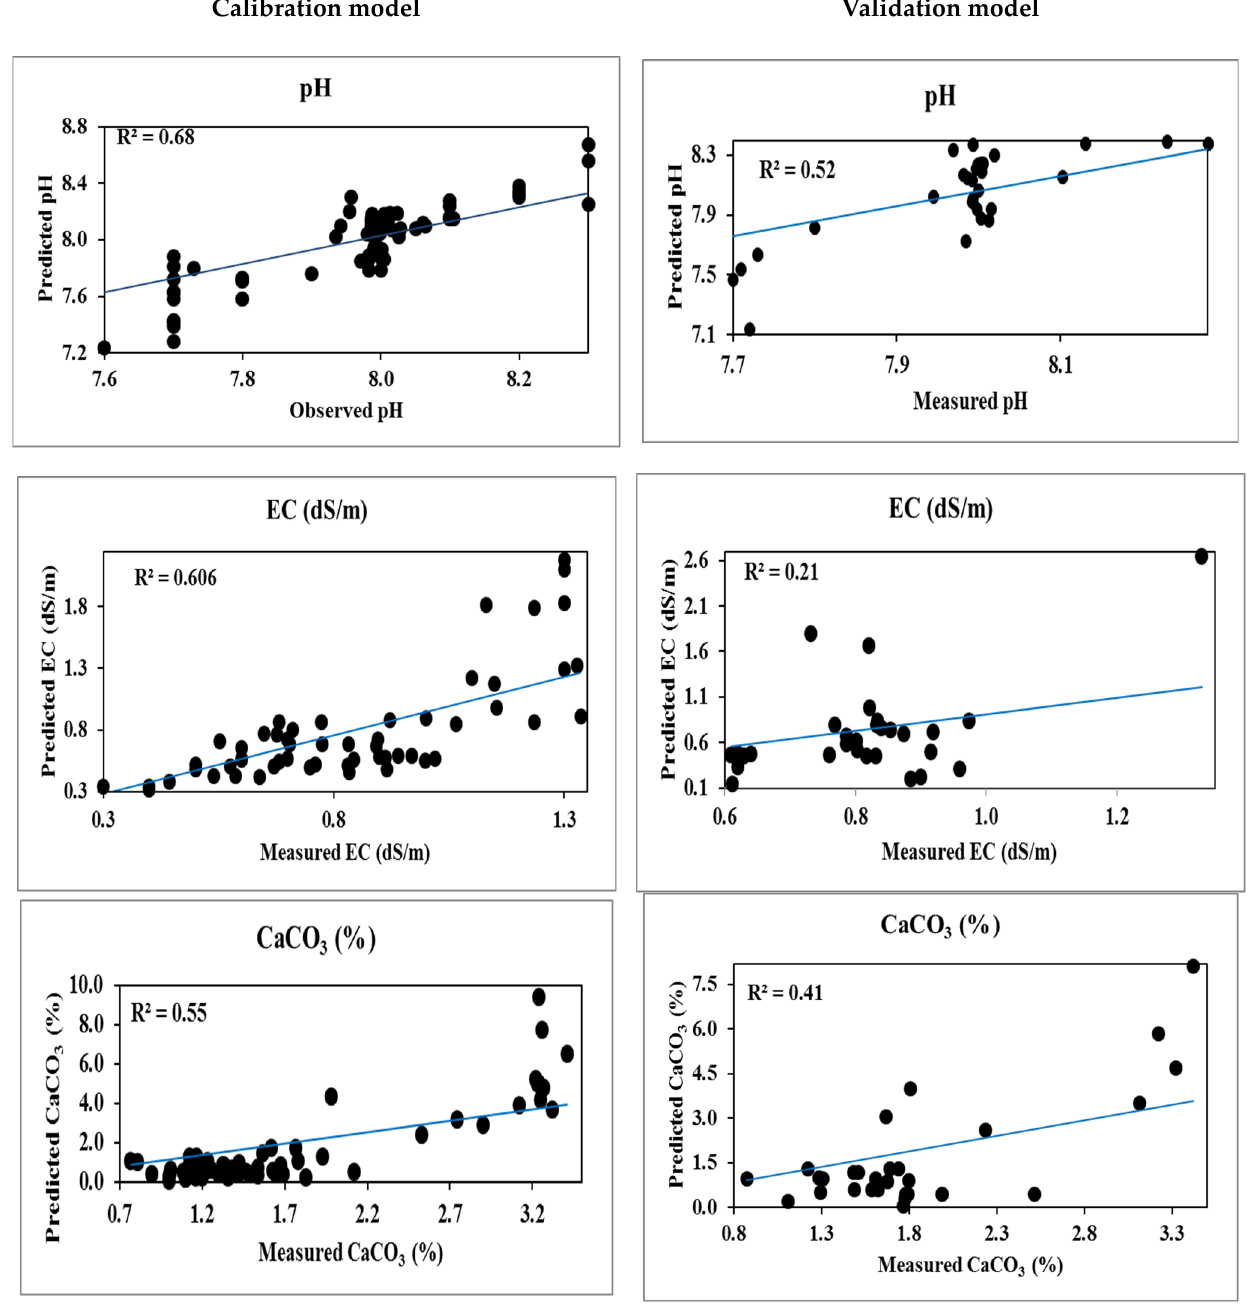
Figure 5. PLSR calibration and validation of soil parameters. For selecting the most correlated or effective bands that were chosen as inputs to derive the PLSR model component for determining the various soil parameters, the CARS technique was applied, as presented in the next Equations (15)– (17).